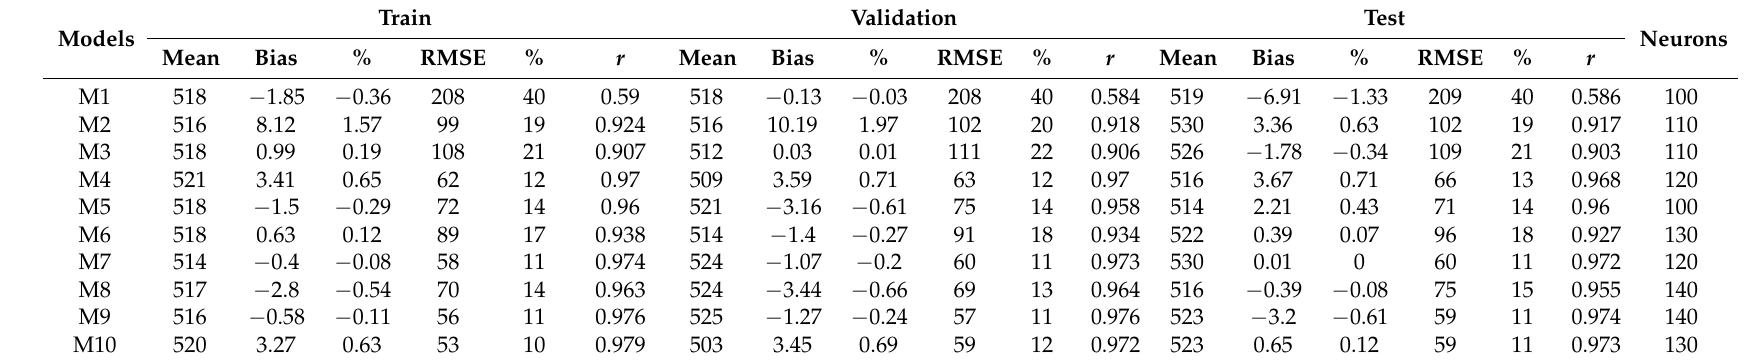
Table A4. As in Table A1, but for Jazhnikan tower